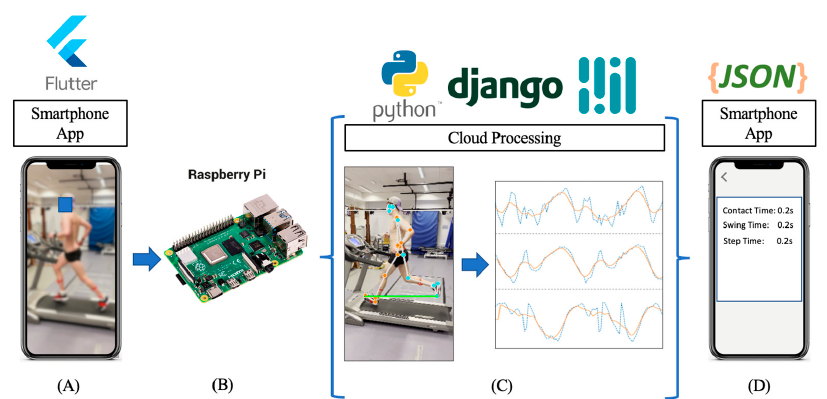
Figure 1. The infrastructure of the smartphone application and its cloud interface. Here, ( A ) the smartphone application captures and uploads side-view videos, transmitting to ( B ) a cloud pro- cessing unit running on a Raspberry Pi 4 where a Python Django implementation of Blazepose esti- mates and ( C ) stores the location of anatomical locations/keypoints, wherein signals are analyzed for gait outcomes. ( D ) Outcomes are then returned to the user via JSON for interpretation in the smartphone